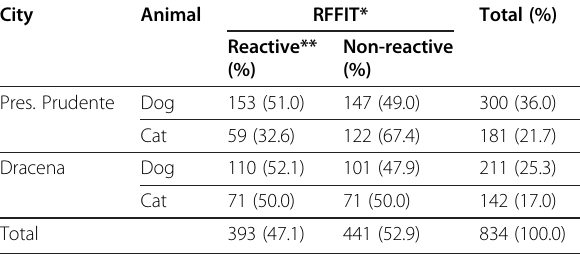
Table 1 Humoral immune response in cats and dogs vaccinated against rabies in Dracena and